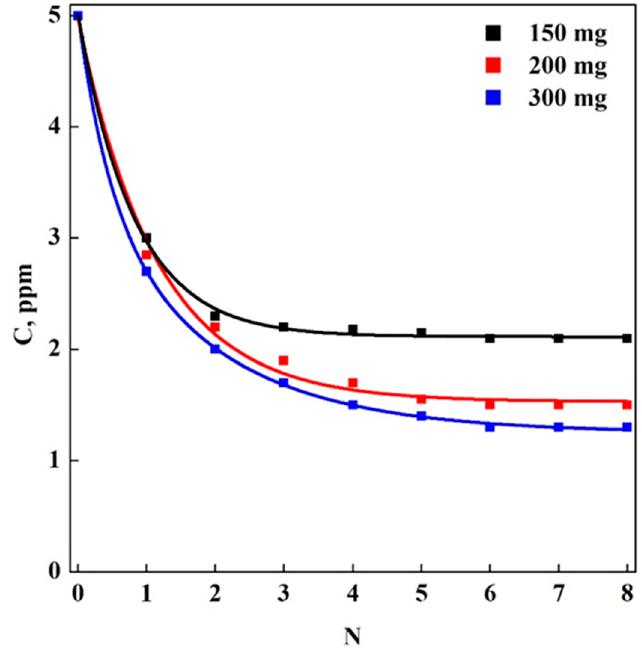
Figure 6. Adsorption kinetics of cryogel samples analyzed in the experiments of Set C (Cryogels) performing a multi-step adsorption (T = 25 °C, flow rate = 0.1 mL/min) and using three different amounts of cryogels: 150 mg (black line), 200 mg (red line) and 300 mg (blue line).